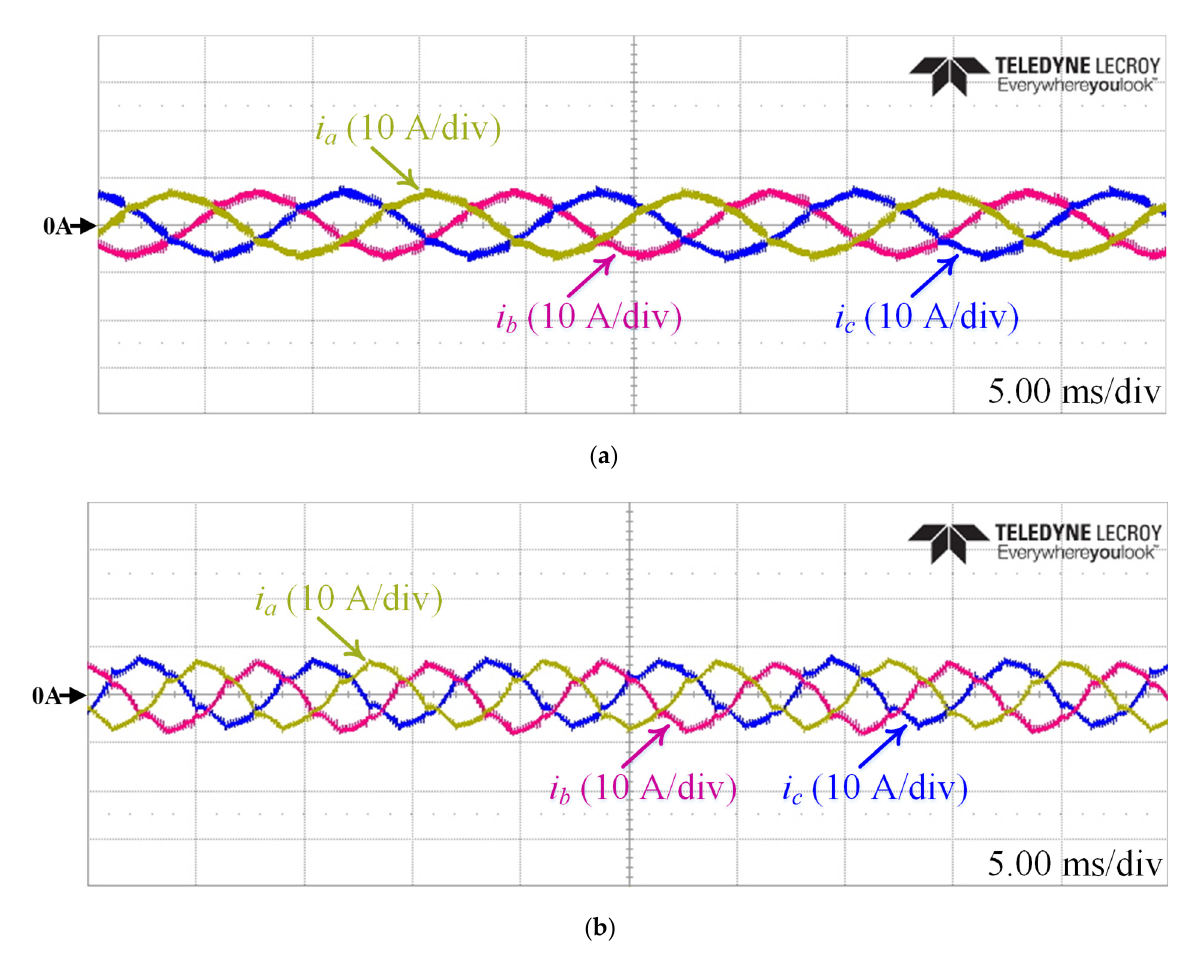
Figure 23. Experimental results of three-phase current at rated load current: ( a ) At rotor speed of 1000 rpm; ( b ) At rotor speed of 1500 rpm.